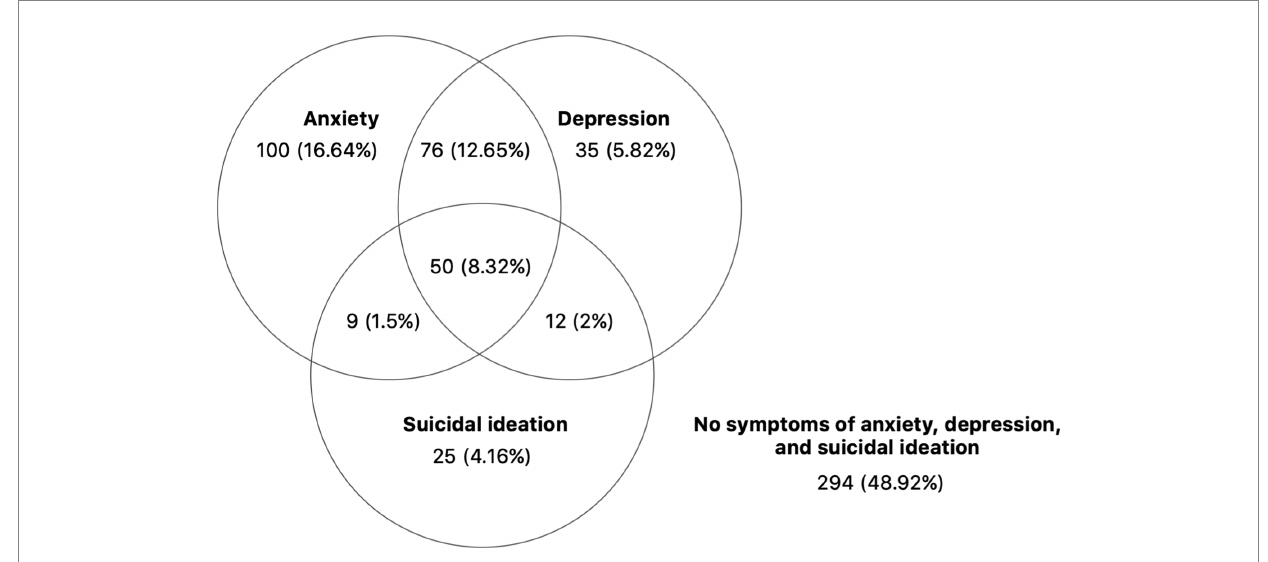
FIGURE 1 Comorbidity of anxiety, depression, and suicidal ideation. This graph displays the proportion of participants classified with each of the three mental health disorders in October 2020 and March 2021 (Total: